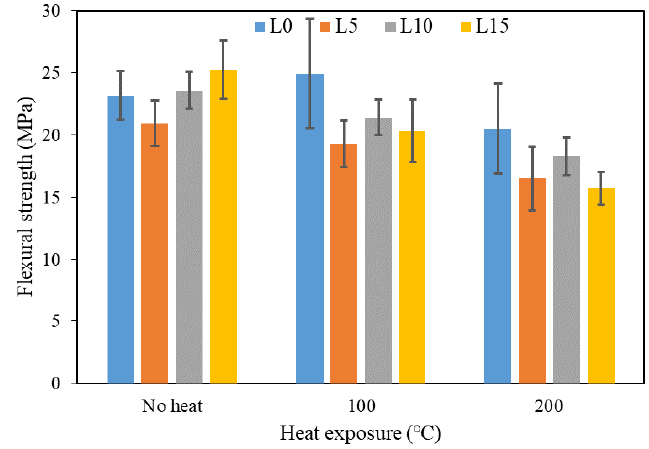
Figure 5. Flexural strength of UHPC mixes.